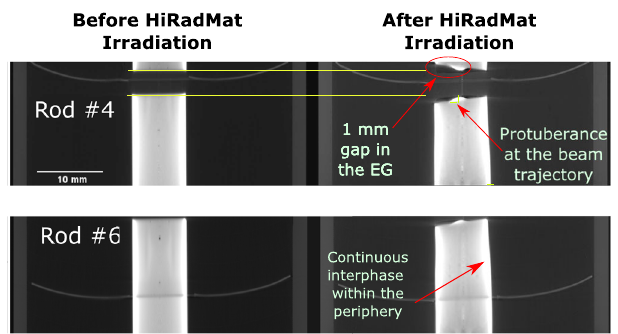
FIG. 9. Images of rods No. 4 and No. 6 of the Ta core obtained from x-ray tomographies performed at ESRF. These tomogra- phies were performed before and after proton irradiation in HiRadMat. Extensive plastic deformation in the Ta core induced by the successive proton beam impacts can be